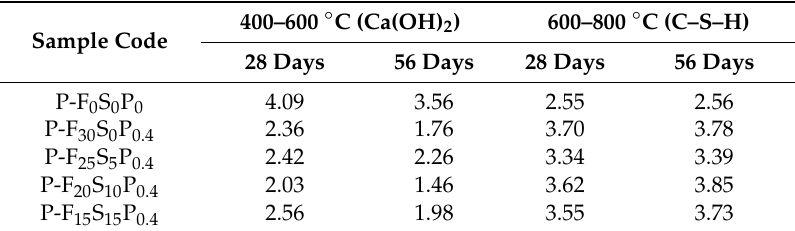
Table 5. The content of portlandite and C–S–H in the hardened cement estimated from the thermogravimetric analysis (TGA)